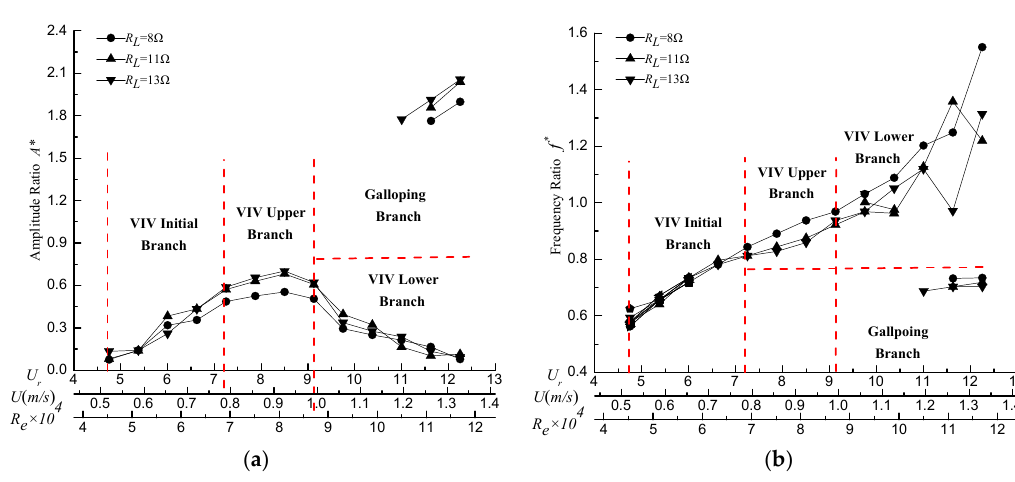
Figure 9. High galloping (HG) oscillation characteristics 8 Ω ≤ R L ≤ 13 Ω (0.208 ≤ ζ ≤ 0.305): ( a ) response of the amplitude ratio; ( b ) response of the frequency ratio.